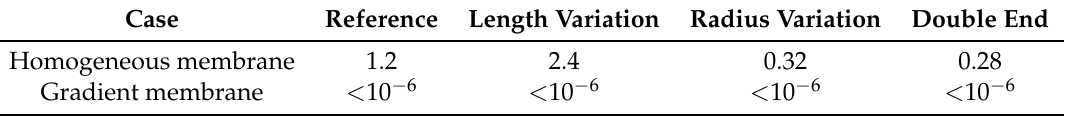
Table 2. Inhomogeneity of flux profile as quantified by the dimensionless flow-rate weighted variance of flux f / J 2 .